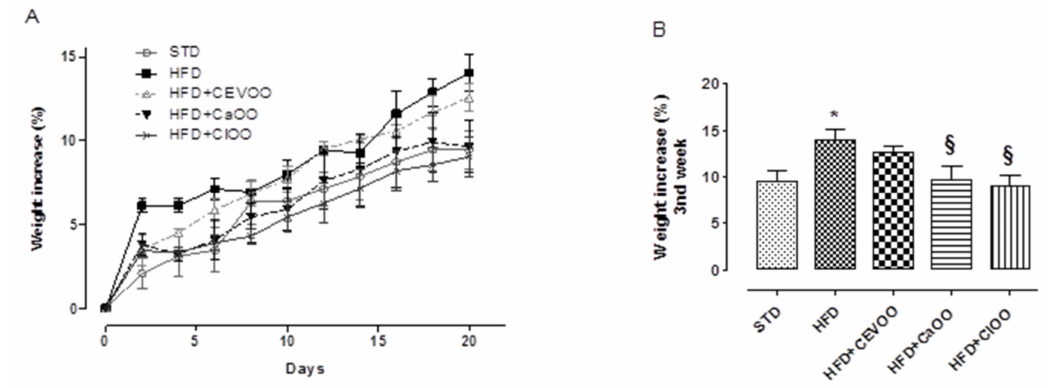
Figure 3. ( A ) Time course of the weight gain of animals during three weeks of treatment. ( B ) Final weight gain of the animals at the third week of treatment (end of treatment). * indicates a statistically significant di ff erence between the HFD group and the STD group. § indicates statistically significant di ff erence between HFD and HFD + CEVOO or HFD + Ca OO or HFD + Cl OO. Single symbol corresponds to p <